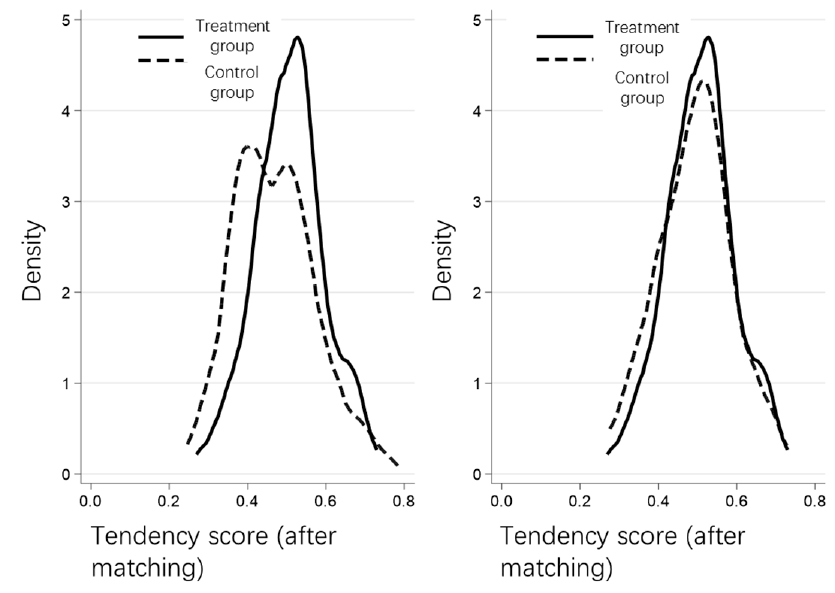
Figure 3. Kernel density function curve.